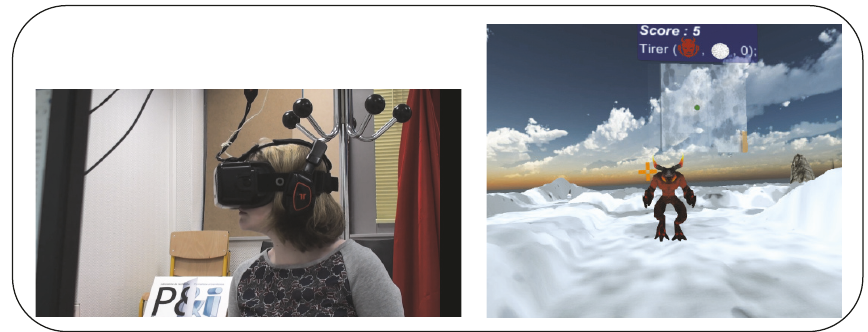
Figure 2: A participant (left) playing the “Think and Shoot” virtual environment